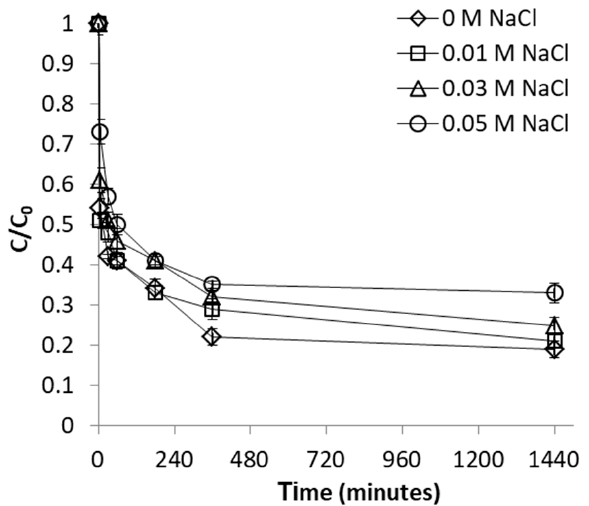
Figure 7. Effect of ionic strength on Fe II removal by WSP. The lines are not fitting models; they simply connect points to facilitate visualization.